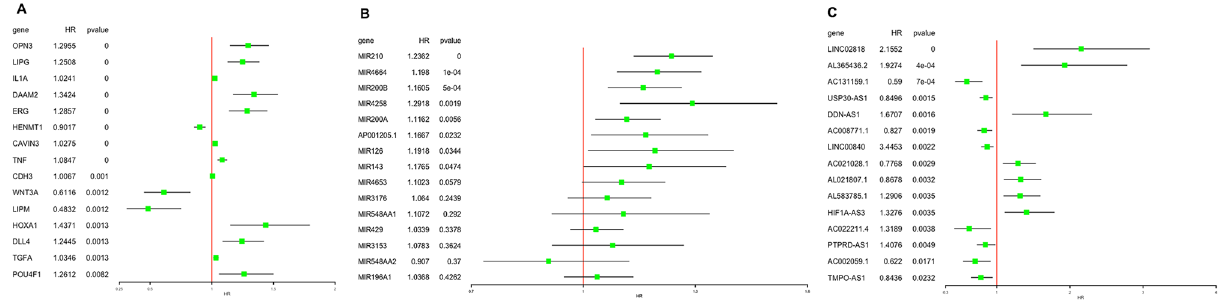
Figure 3. Forest plot of the hazard ratios of the top 15 survival-associated ( A ) mRNAs, ( B ) miRNAs, and ( C ) lncRNAs. A hazard ratio > 1 indicates the high-risk RNAs, and a hazard ratio < 1 indicates a protective